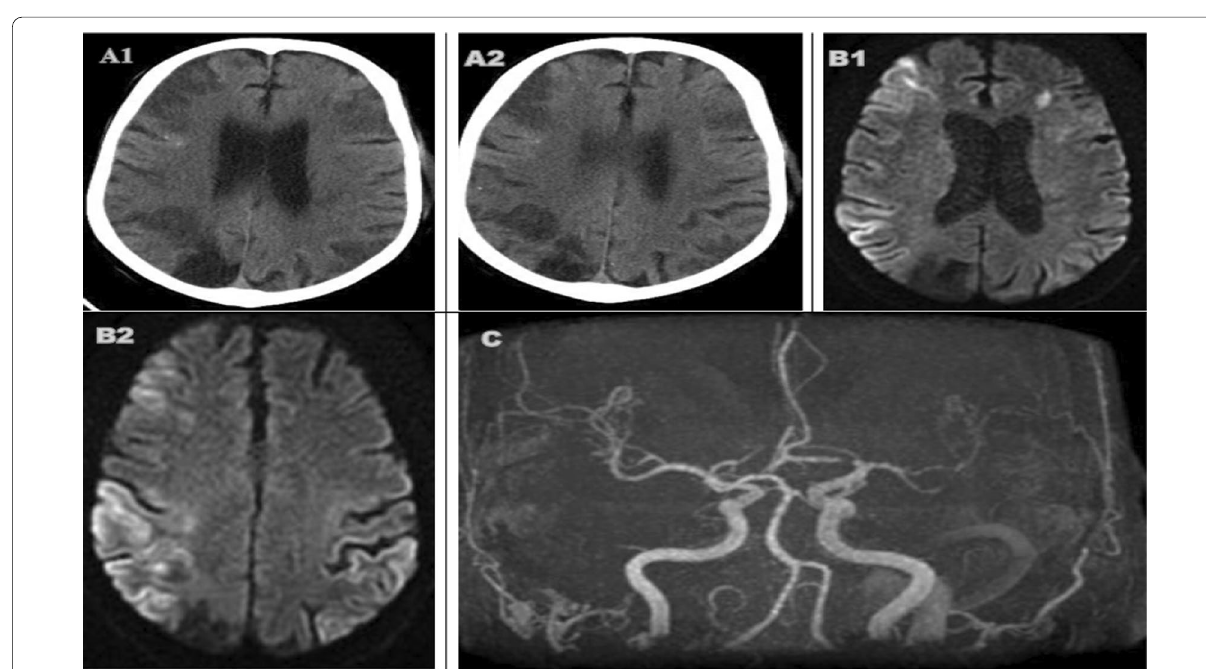
Fig. 3 A 64‑years‑old man with old right occipital old stroke and multiple scattered calcific emboli, presented with delayed neurological recovery after CABG. CT brain ( A1 , A2 ) showed acute hypo‑densities in bilateral fronto‑parietal and right occipito‑temporal regions representing watershed infarctions. MRI ( B1 , B2 ) was done after 6 days and showed external and internal watershed infarctions involving bilateral cortical and subcortical areas. MR angiography ( C ) demonstrates multifocal moderate‑to‑severe bilateral middle cerebral arteries stenosis associated with paucity of